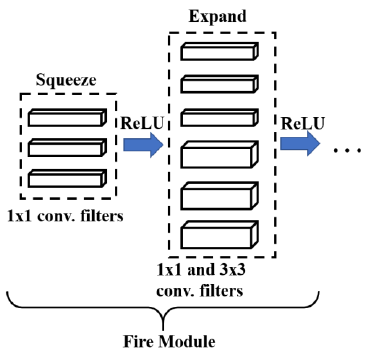
Figure 1. The fire module in Squzeenet micro-architectural overview